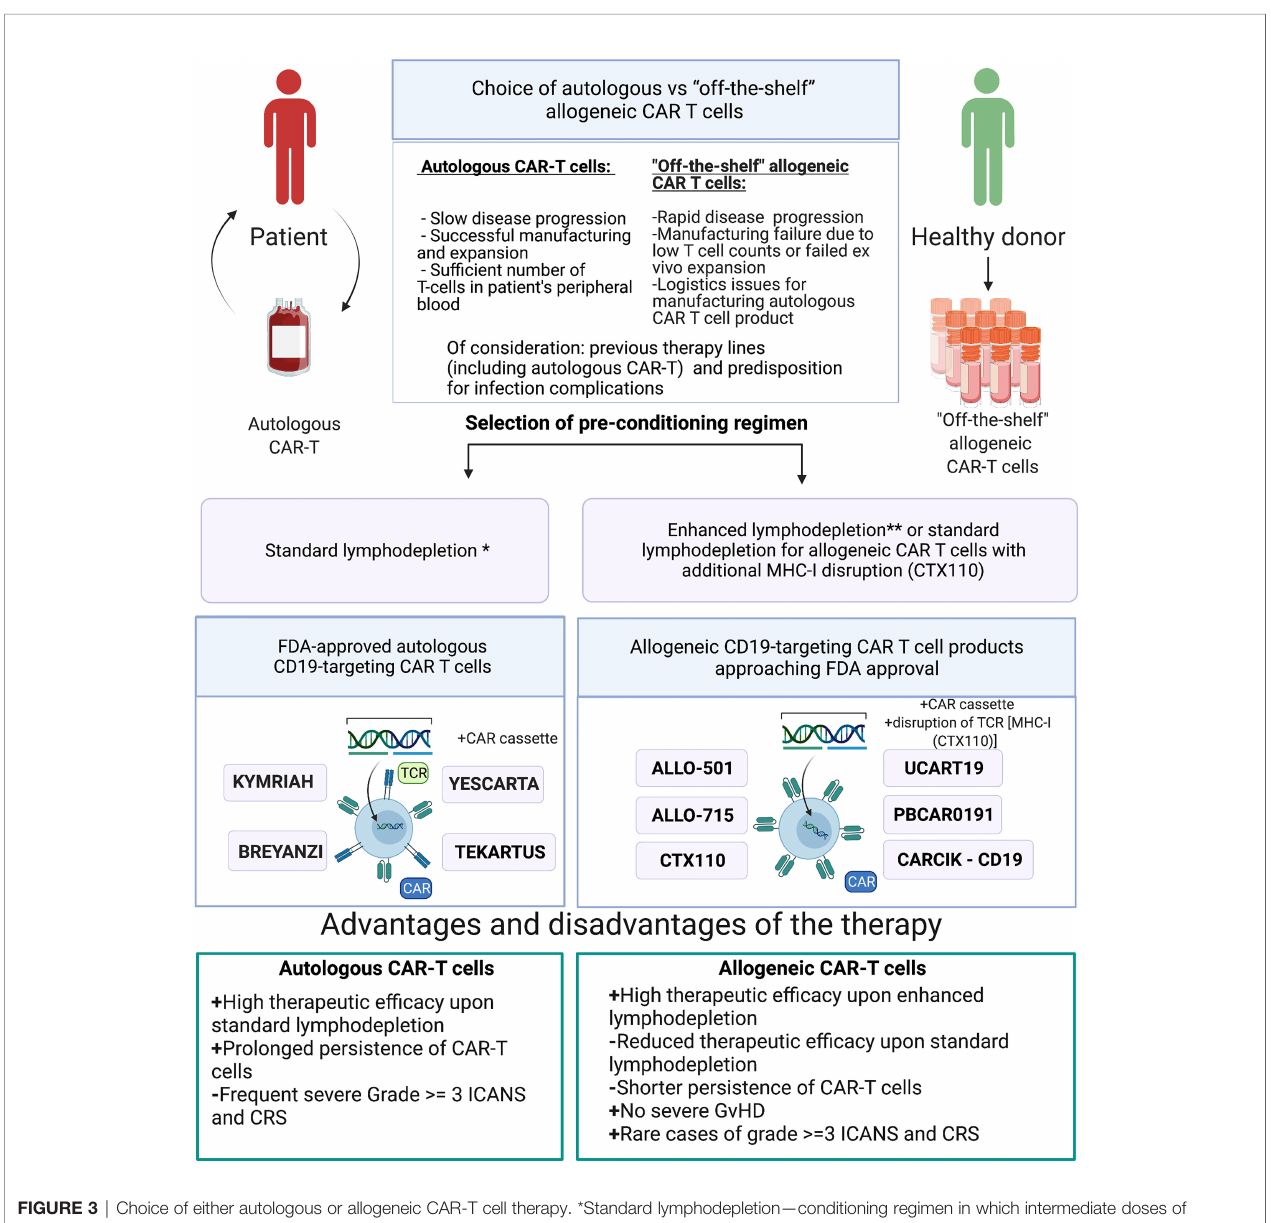
FIGURE 3 | Choice of either autologous or allogeneic CAR-T cell therapy. *Standard lymphodepletion — conditioning regimen in which intermediate doses of chemotherapy drugs are applied. **Enhanced lymphodepletion — conditioning regimen in which high doses of chemotherapy drugs and/or additional biologic medications (monoclonal antibody, including allo-647) are